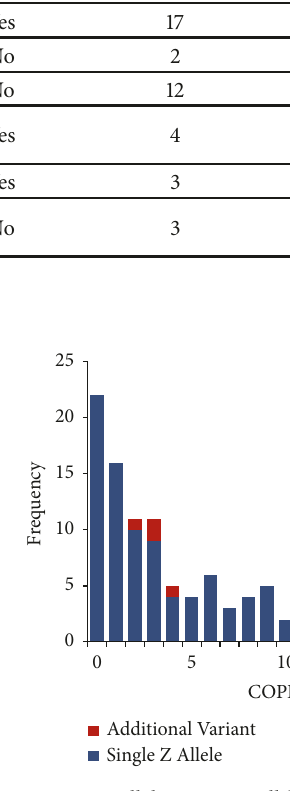
Figure 2: Biallelic variants all had COPD severity scores > 1. The distribution of COPD severity scores for all study participants is